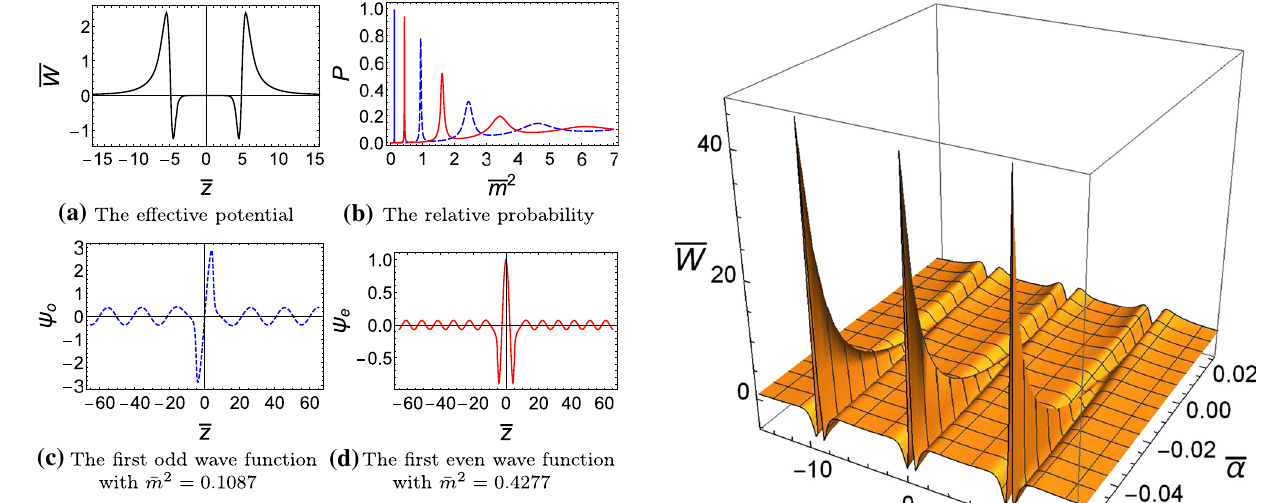
Fig. 12 The effective potential, the relative probability, and the wave functions of the first odd and even KK resonances with ¯ b = 10 and ¯ α = − 0 . 0012 for case 1